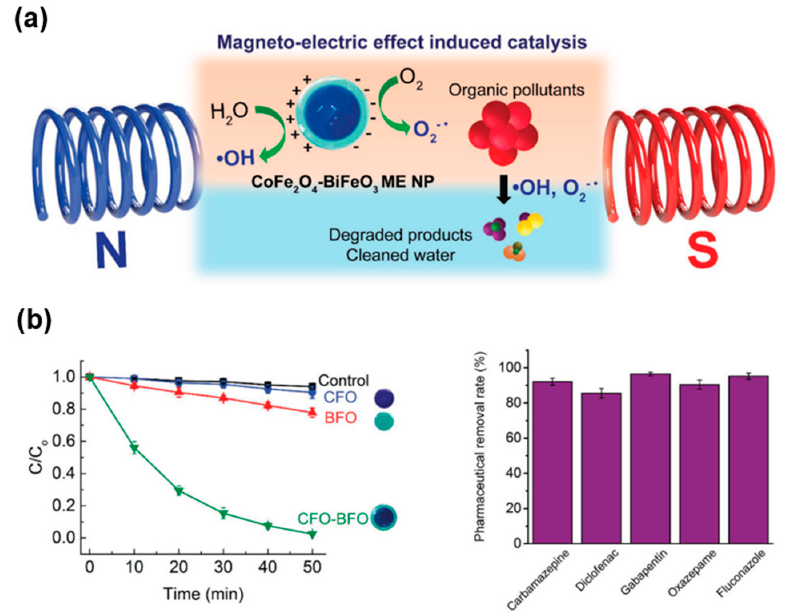
Figure 9. Applications of MENPs as degradation catalysts for wastewater purification. ( a ) Schematic shows the degradation of organic pollutants using MENPs as ME effect-induced catalysts. ( b ) Ef- fective reduction of the pollutant concentration within 50 min and removal of various common in- dustrial-grade pollutants using MENPS. The figure and data are showcased by Mushtaq et al. Re- produced with permission from [48]. Copyright 2019, Wiley-VCH.